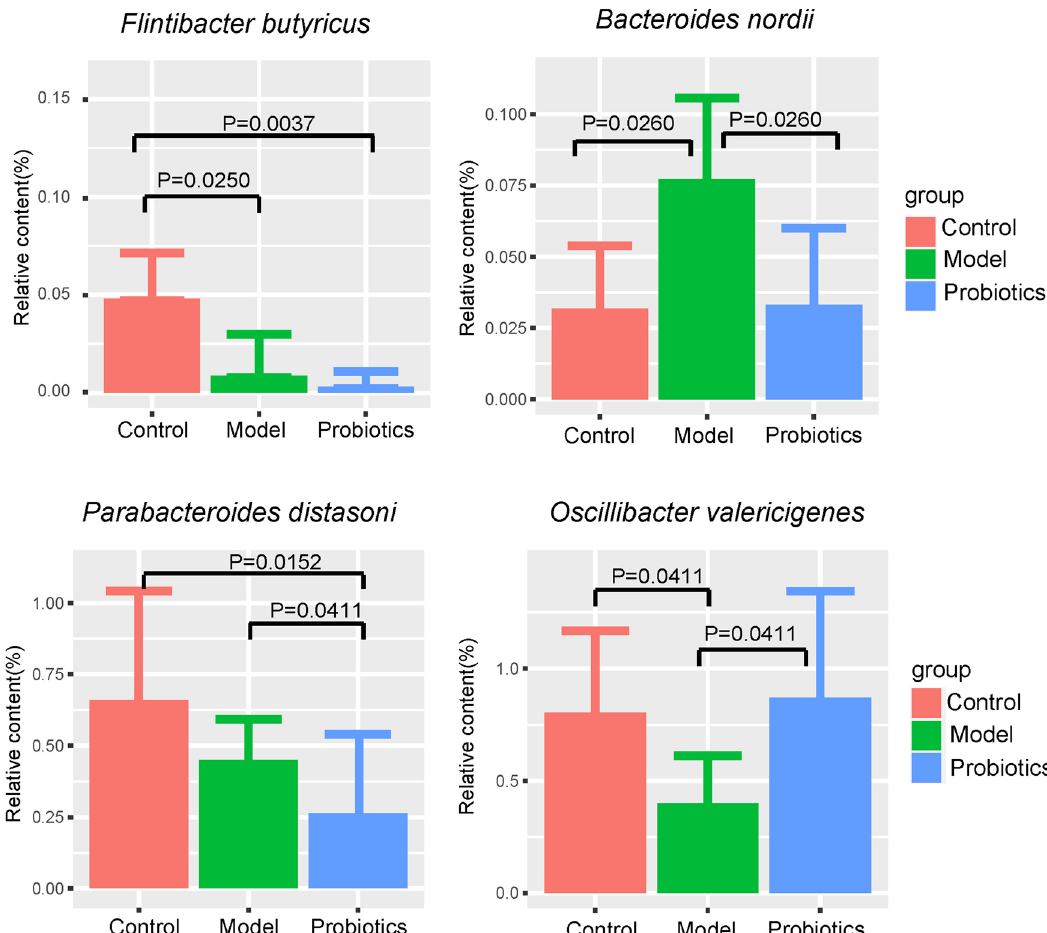
Figure 3: Signi fi cant di ff erential species among the control group, the model group, and the probiotic group. P value of < 0.05 was considered statistically signi fi